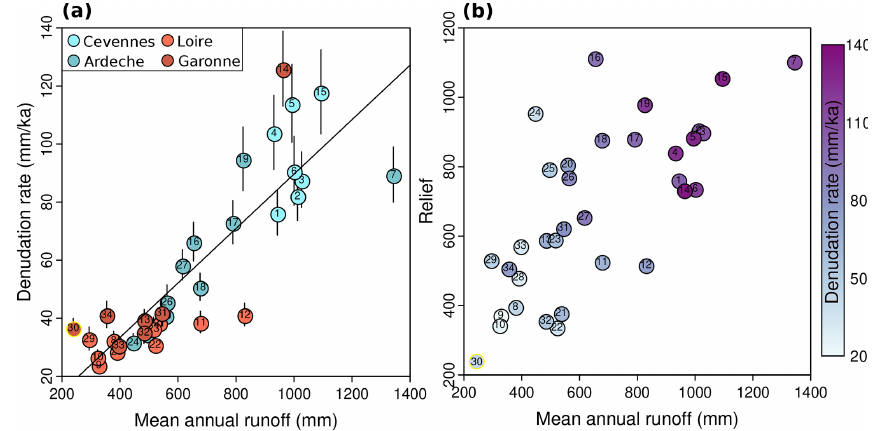
Figure 8. (a) Denudation rates against basin mean annual runoff calculated using the calibration of Fig. 4. Symbols are colored according to the four different subregions, and the black solid line is a linear fit to the data. (b) Basin relief against mean annual runoff. Symbols are colored according to the denudation rates of the